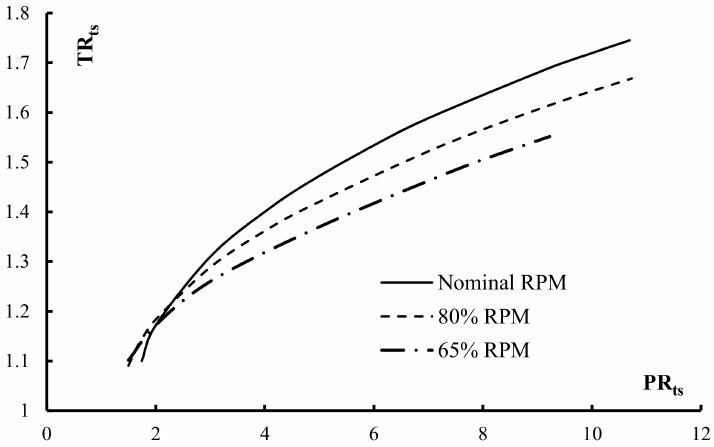
Figure 16. Evolution of total-to-static temperature with total-to-static pressure for the new design of RI turbine.